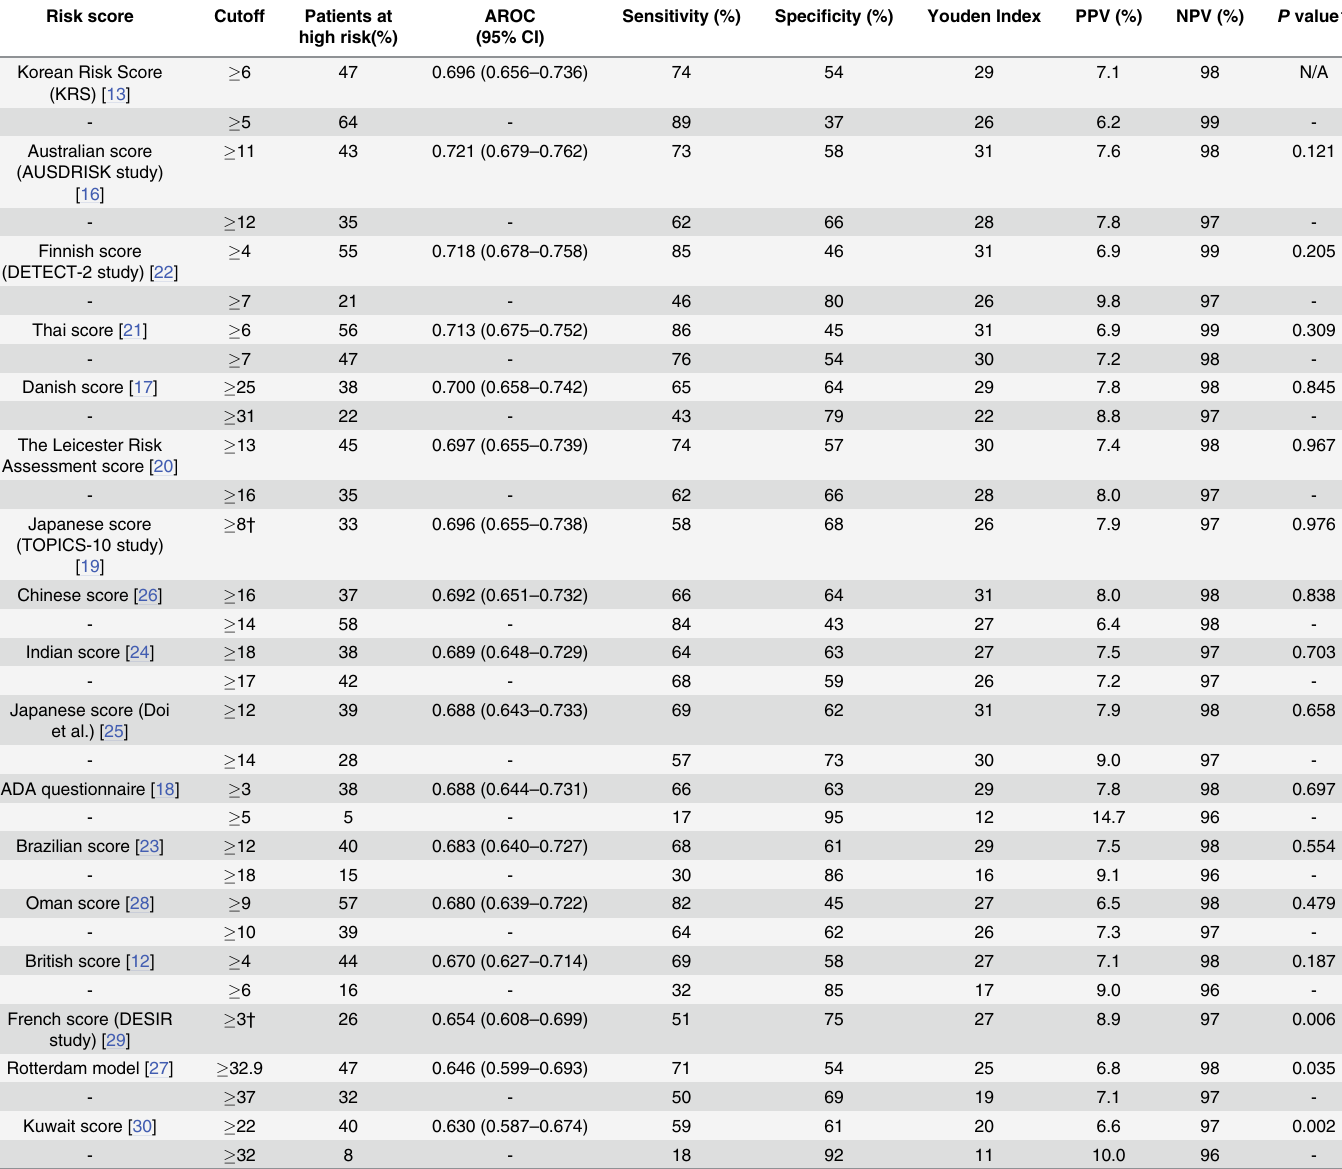
Table 3. Performance of risk scores in longitudinal validation for the prediction of incident diabetes. Risk score